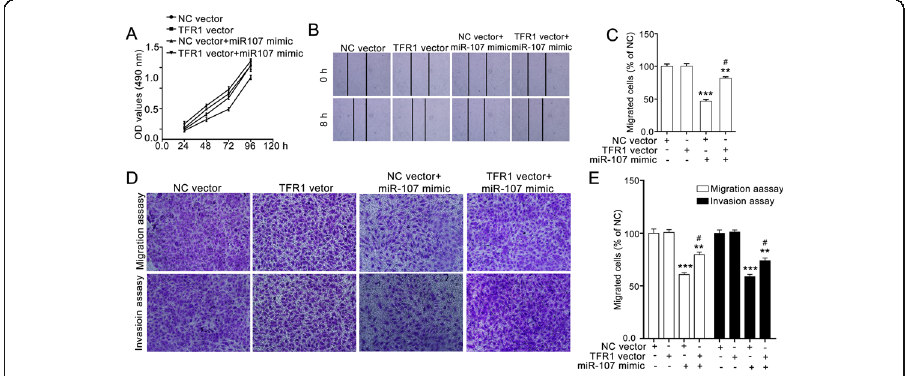
Fig. 4 TFR1 overexpression restored the miR-107-mediated inhibitory effect on SW620 cells. a TFR1 overexpression attenuated miR-107-induced suppressive effect on SW620 cells. SW620 cells were treated with NC mimic or miR-107 mimics for 24h, and then the cell viabilities were determined with the MTT assay. b and c TFR1 overexpression restores the miR-107-mediated effect on the horizontal migration of SW620 cells. SW620 cells were transfected with NC vector or TFR1 vector, and then used for the wound-healing assay. Representative images (100× magnification) and quantitative data are shown in ( b and c ), respectively. d and e TFR1 overexpression attenuates the miR-107- mediated suppressive effect on the vertical migration and invasion of SW620 cells. The SW620 cells were transfected with NC vector or TFR1 vector, and then subjected to transwell migration and transwell invasion assays. Representative images (100×magnification) and quantitative data are shown in ( d and e ), representatively. Quantitative data are presented as the means ± SEM. *** p <0.01 and *** p <0.001 compared with NC vector group, # p <0.05 compared with NC vector+miR-107 mimic